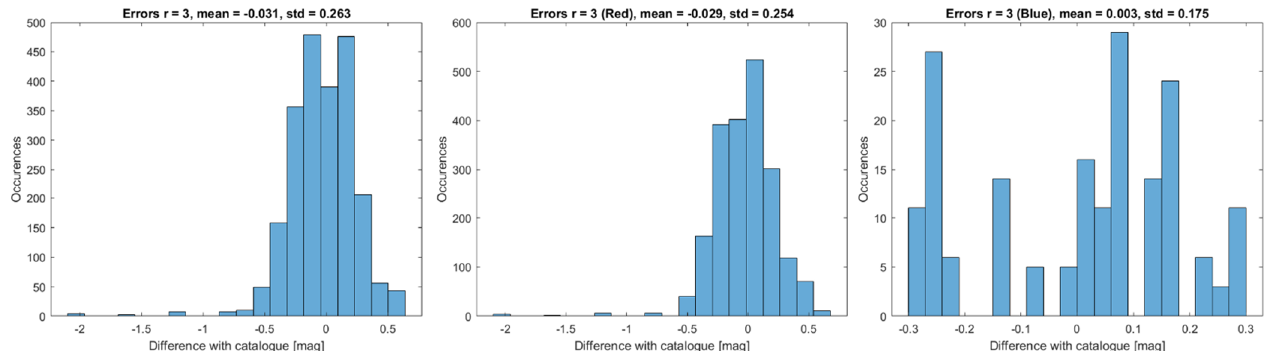
Figure 1. The figure shows how the mean and the standard deviation of the difference between the catalogued and calculated magnitude, decrease using stars with the same spectral class. On the left is shown the histogram obtained using all the stars present in the video recording, on the center using only the red stars and, on the right, using only the blue stars.